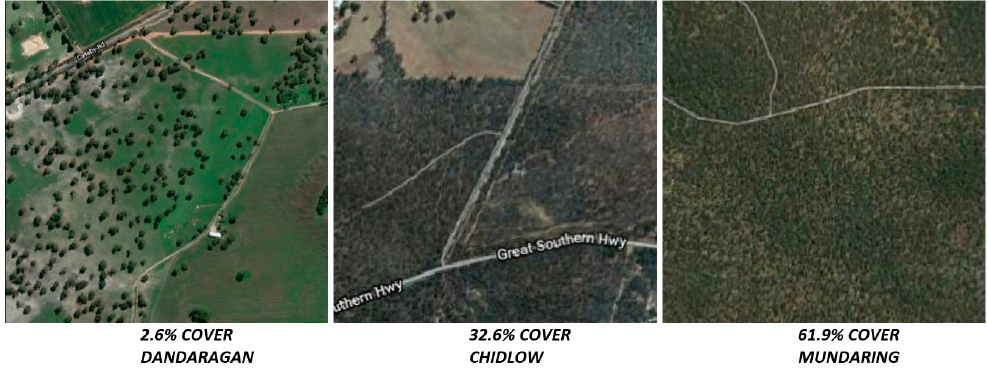
Figure 3. Examples of the minimum, median and maximum mature canopy cover across the apiary sites (images are all 1 km × 1 km extent).